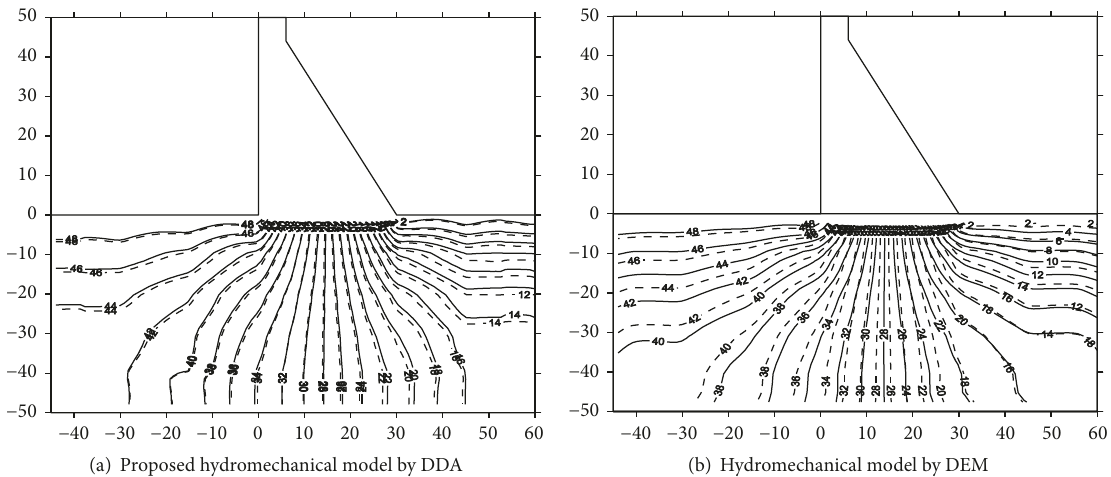
Figure 4: Water head contours for coupling (solid line) and initial condition (dashed line) (m).